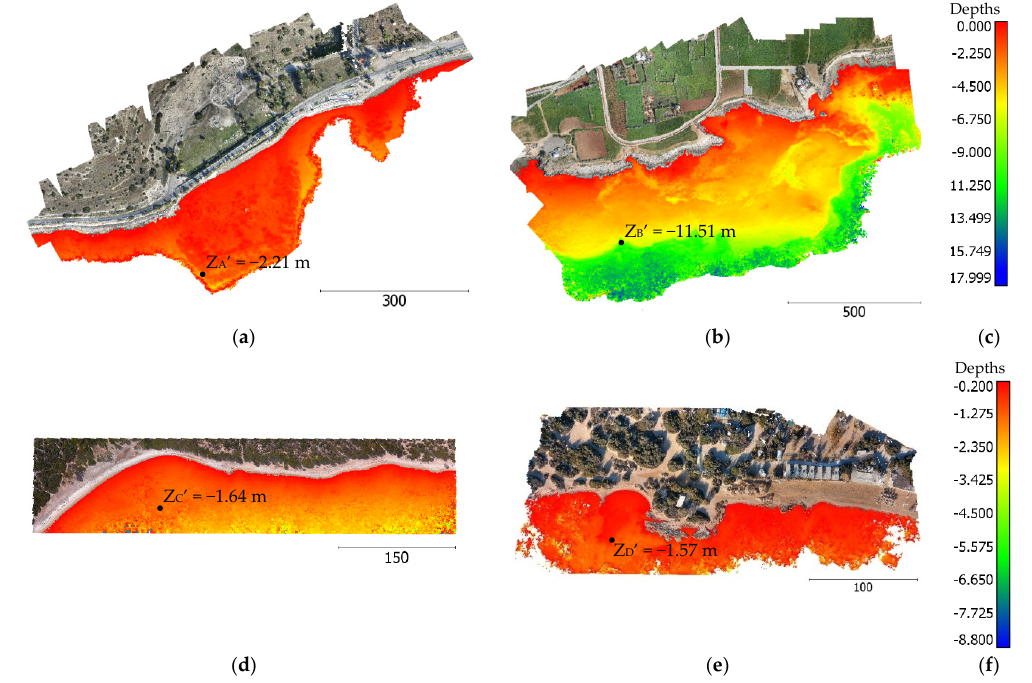
Figure 4. The extracted seabed point clouds after the depth correction for Amathounta ( a ), Agia Napa ( b ), Cyclades-1 ( d ), and Cyclades-2 ( e ) test sites. In ( c ) and ( f ) the color scale of the depths is illustrated. Z X ’ is the corrected depth of the point marked with the black dot in each point cloud. Scale bars and depths are in meters.